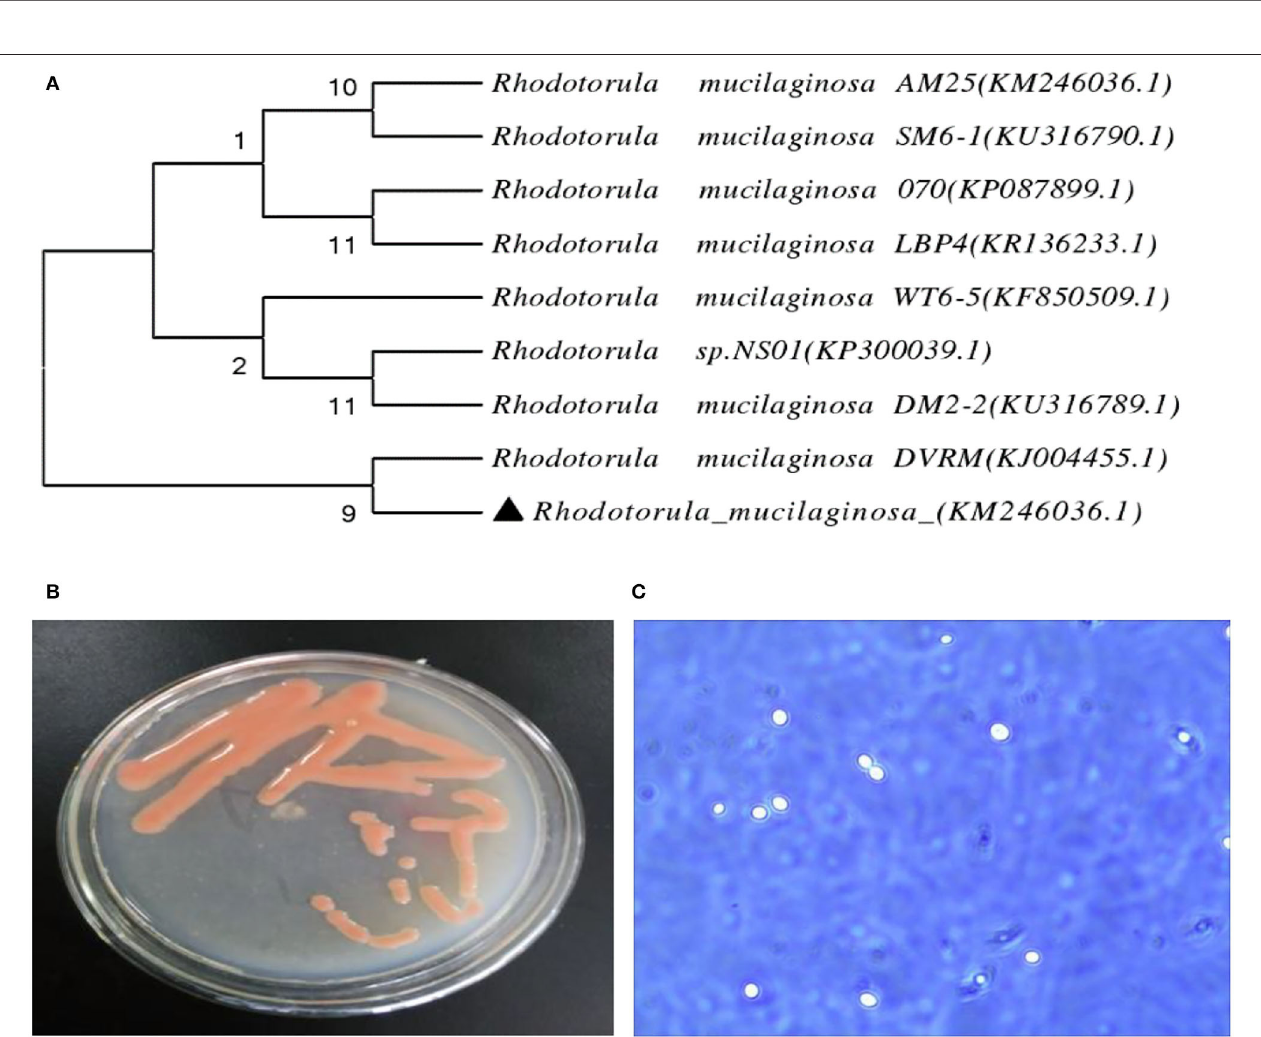
FIGURE 1 | The phylogenetic tree of Rhodotorula mucilaginosa TZR 2014 (A) , the visual colony morphology (B) , and the cell morphology of Rhodotorula mucilaginosa TZR 2014 (C) .